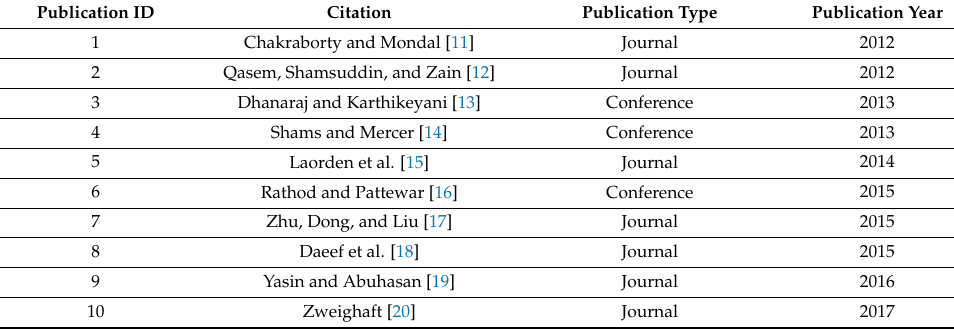
Figure 6. Number of journal and conference publications per year from 2012 to 2022. Table 2. Retrieved publications that are related to the research